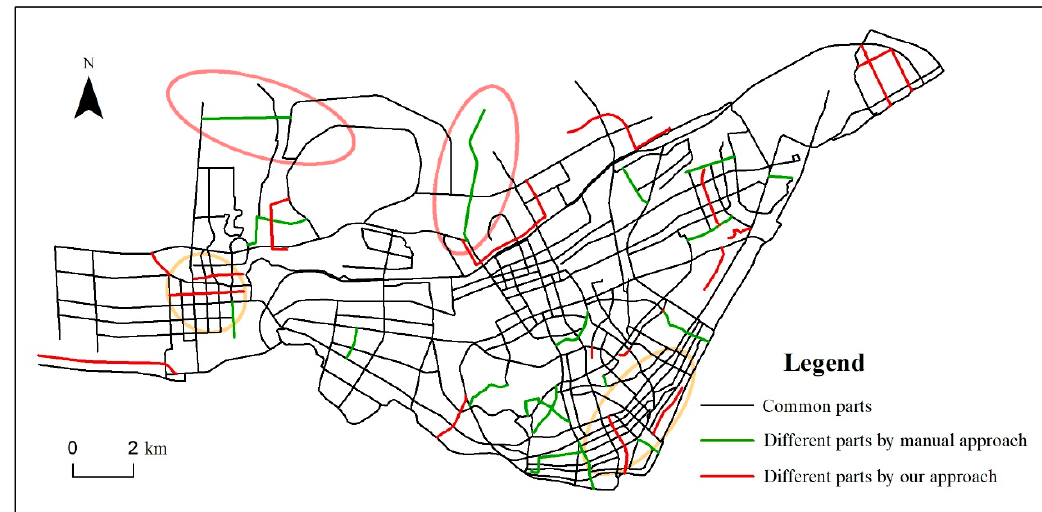
Figure 12. Comparison between our method and manual method. Our method is still unable to reach desired effects in all aspects due to some non-optimal parts of the method. Slight thinning was needed in denser areas (in the orange circles). Some roads (in the pink circles) that reflected significant structural features of the network were pruned. Table 7. Statistics of maximum similarity and its related